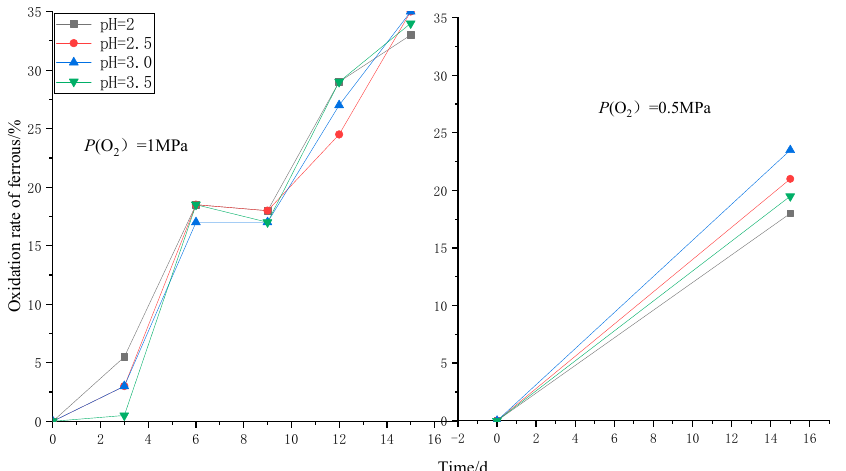
Figure 5. ( a ) Oxidation rate of Fe(II) under different pH with oxygen ( b ). Oxidation rate of Fe(II) under different pH with H 2 O 2 (Fe(II) concentration is 2 g/L).